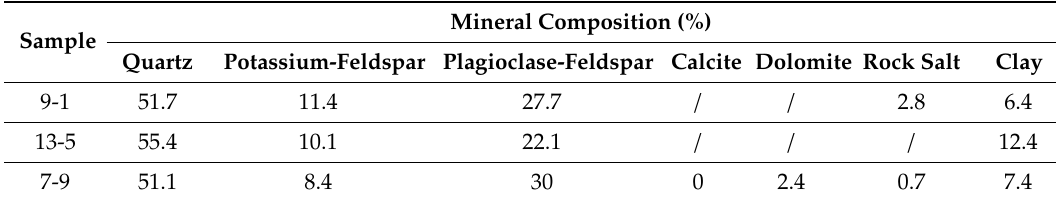
Table 1. Compositional analysis by X-ray di ff raction